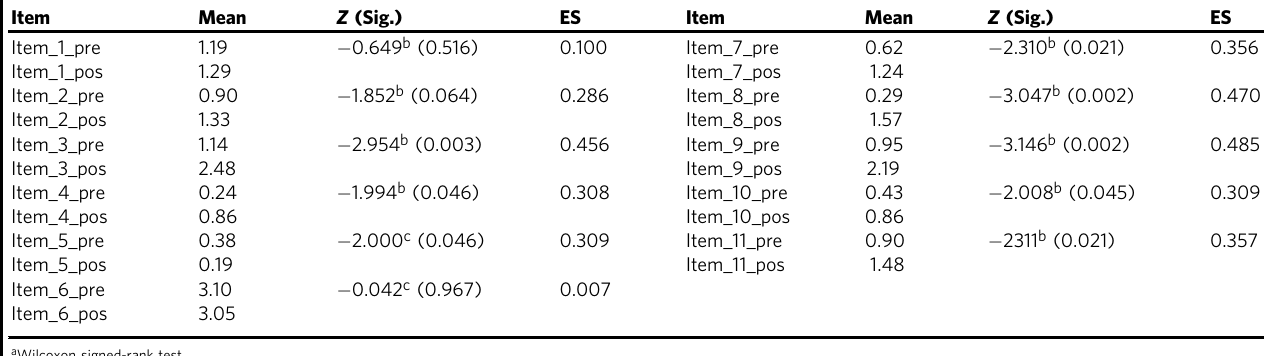
Table 5 Descriptive statistics of the control group in the pretest and posttest.